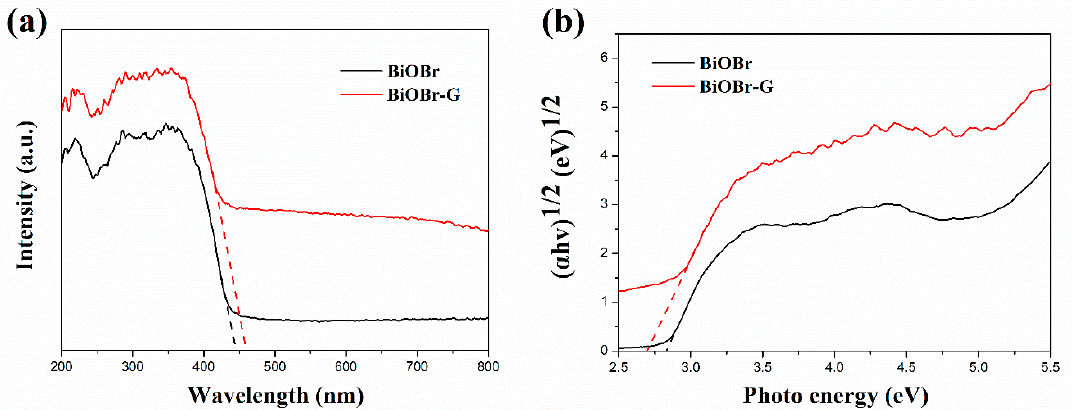
334 Figure 6. ( a ) Diffuse reflectance spectra (DRS) and ( b ) Tauc plots of the BiOBr and BiOBr-G nanocomposites.